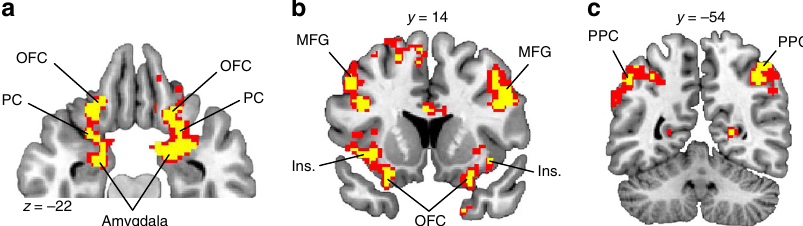
Fig. 4 Neural correlates of iPE outside the midbrain. Outside the midbrain ROI, whole-brain analysis of correlations with iPE revealed responses in a piriform cortex (PC), orbitofrontal cortex (OFC), amygdala, b middle frontal gyrus (MFG), insula (Ins.), and c posterior parietal cortex (PPC). T-maps are displayed at p < 0.005, uncorrected (red) and p < 0.001, uncorrected (yellow). For a complete list of peak coordinates and effect sizes related to this analysis, see Supplementary Table